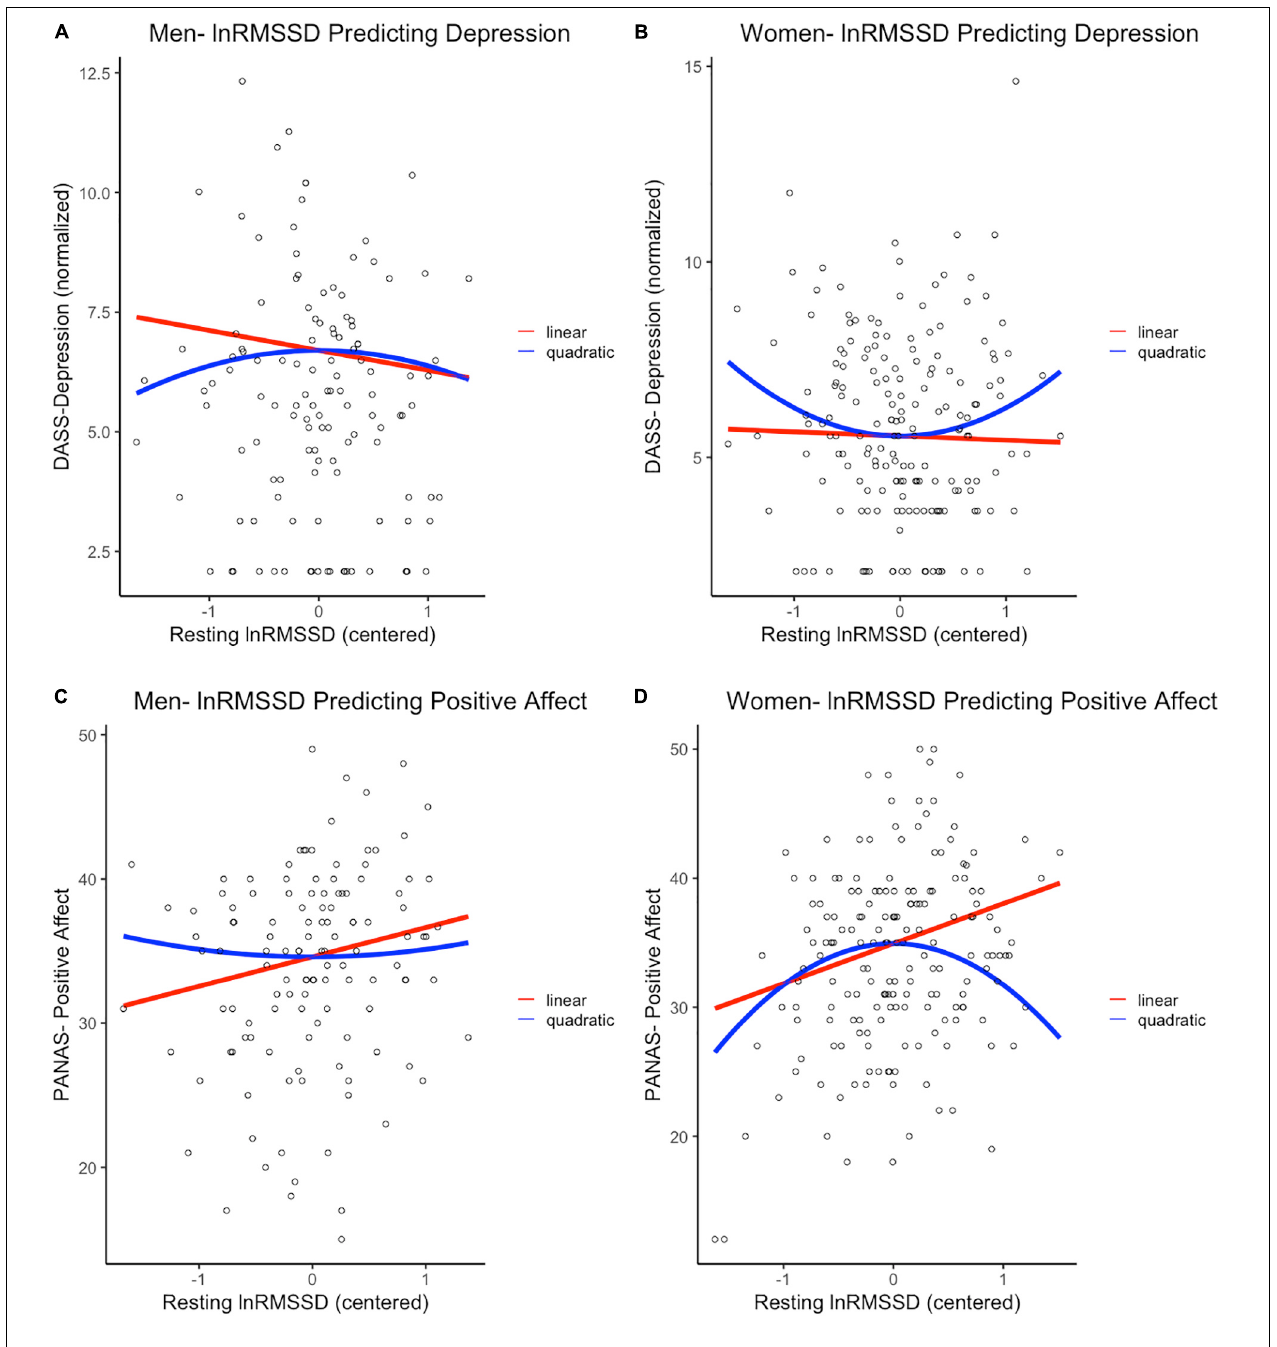
FIGURE 1 | First row: Linear and quadratic effects of resting lnRMSSD on DASS-Depression scores in (A) men and (B) women separately. Second row: Linear and quadratic effects of resting lnRMSSD on PANAS-positive affect scores in (C) men and (D) women separately. LnRMSSD = natural log of root mean square of successive differences (in the natural log of millisecond units). LnRMSSD is grand-mean centered; DASS = depression anxiety stress scale. DASS-Depression scores are in inverse normalized units to reduce skew for parametric analyses. All results were identical ( p < 0.05, one-tailed) when analyzing raw DASS-Depression scores. Significant ( p < 0.05, one-tailed) quadratic effects were only detected in women, as depicted in (B,D)